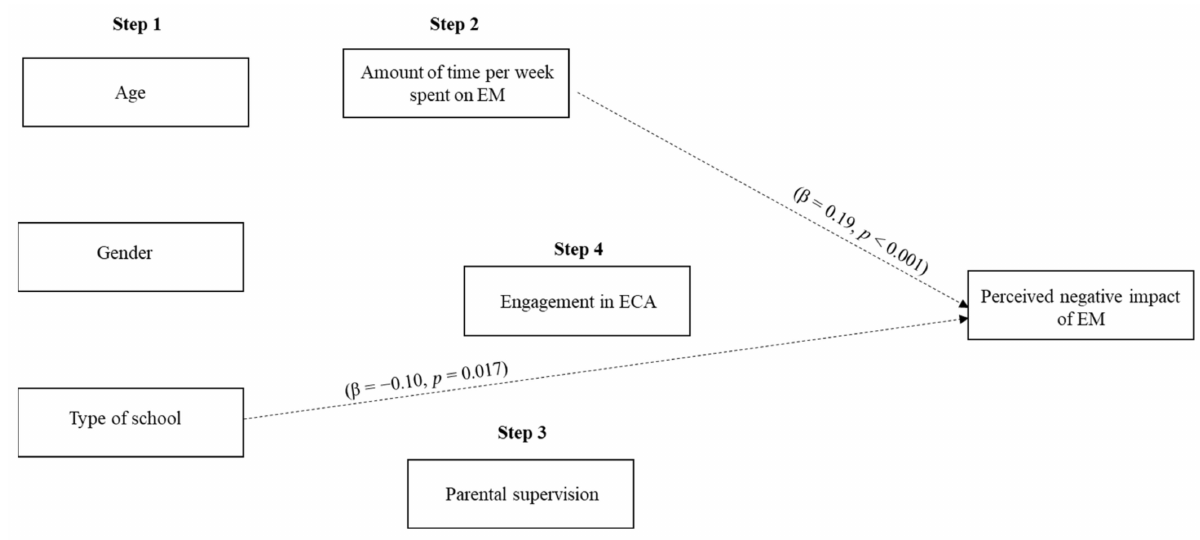
Figure 2. Predictors of perceived negative impact of EM (parents’